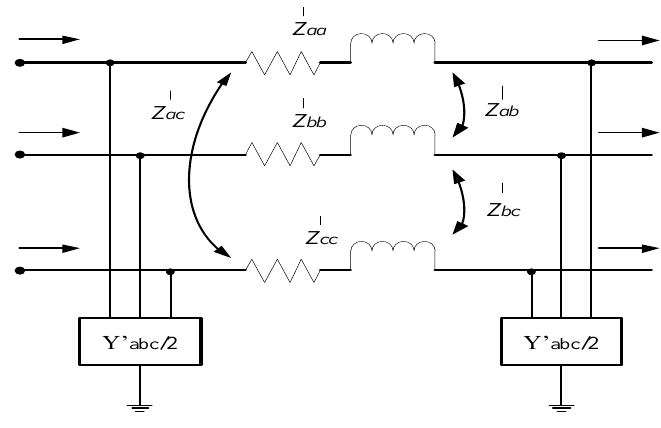
Figure 2. Single-line diagram of the sample power distribution network (PDN).